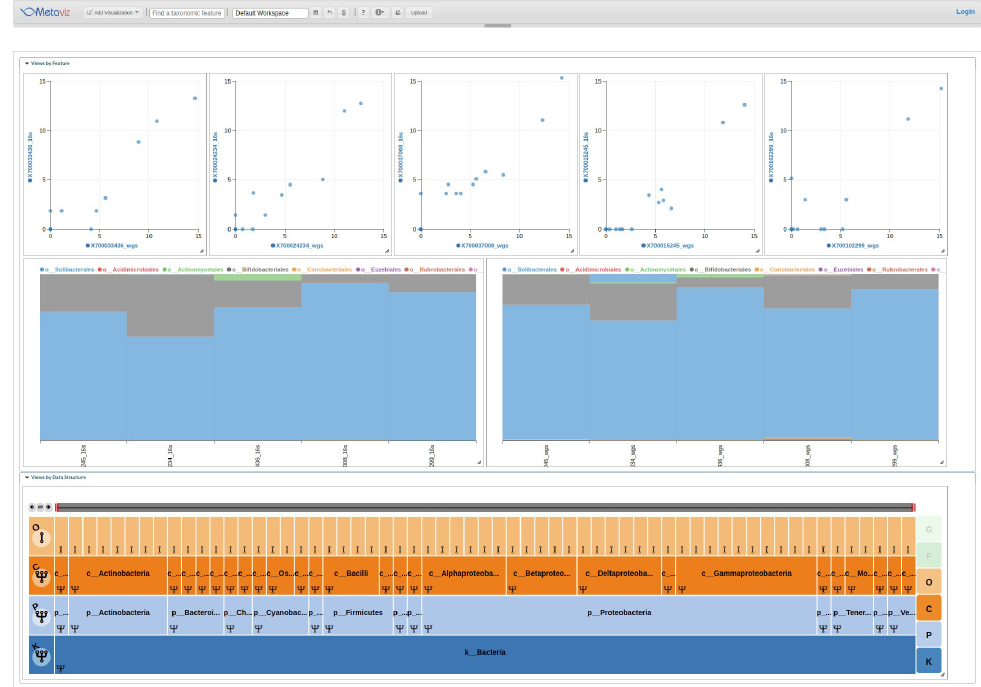
Figure 2. Comparison between 16S and WGS taxonomic profiling using metavizr. We identified taxa present in the taxonomic hierarchy for each method and created a merged dataset. A FacetZoom (bottom) shows the common taxonomic features, two Stacked Plots (middle) show the proportion of all features aggregated to the Order level, and a set of scatter plots (top) for samples with WGS abundance on the X-axis and 16S abundance on the Y-axis. For WGS, the relative proportion output from MetaPhlan for taxa at the order level were transformed to counts per 1000 reads. The scatter plots show the variability in taxonomic community census estimates between sequencing methods. A static similar stacked plot visualization is shown in the main HMP consortium manuscript at the genus and species level across samples for comparison 16 . Metaviz allows users to make specific selections of the FacetZoom to compare taxa at various levels. The scatter plot also allows comparison at single sample resolution. Code to create this Metaviz session is available at the following